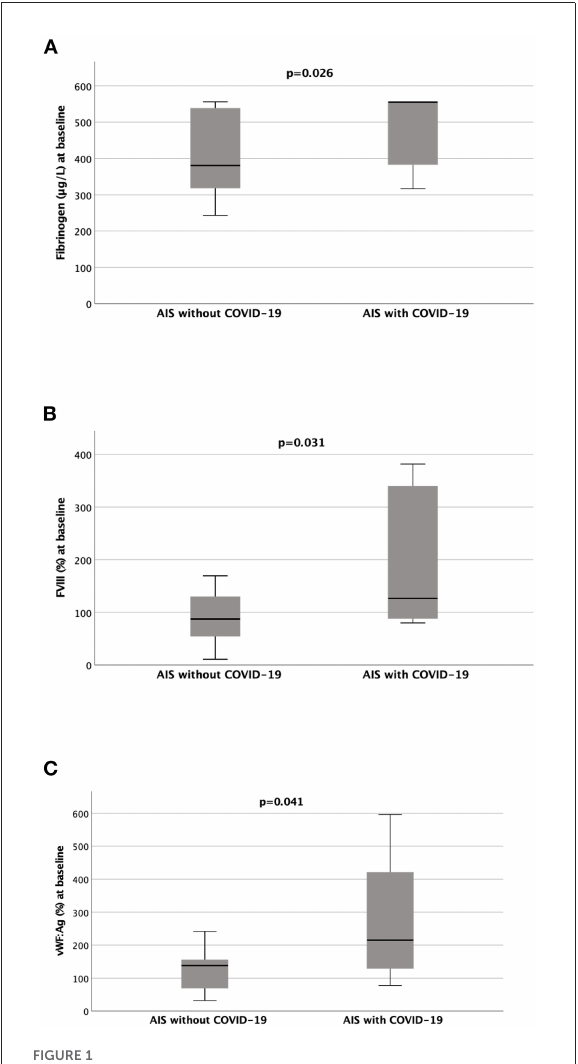
FIGURE1 Fibrinogen, FVIII and VWF:Ag circulating levels are significantly higher in COVID-19 acute ischemic stroke patients than in the non-COVID-19 acute ischemic stroke patients. The graphs show the differences (Mann-Whitney U test) in coagulation parameters between acute ischemic stroke (AIS) patients with COVID-19 and without COVID-19: (A) Fibrinogen (without COVID-19, n = 14 vs. with COVID-19, n = 20); (B) Factor VIII (FVIII) (without COVID-19, n = 10 vs. with COVID-19, n = 8);